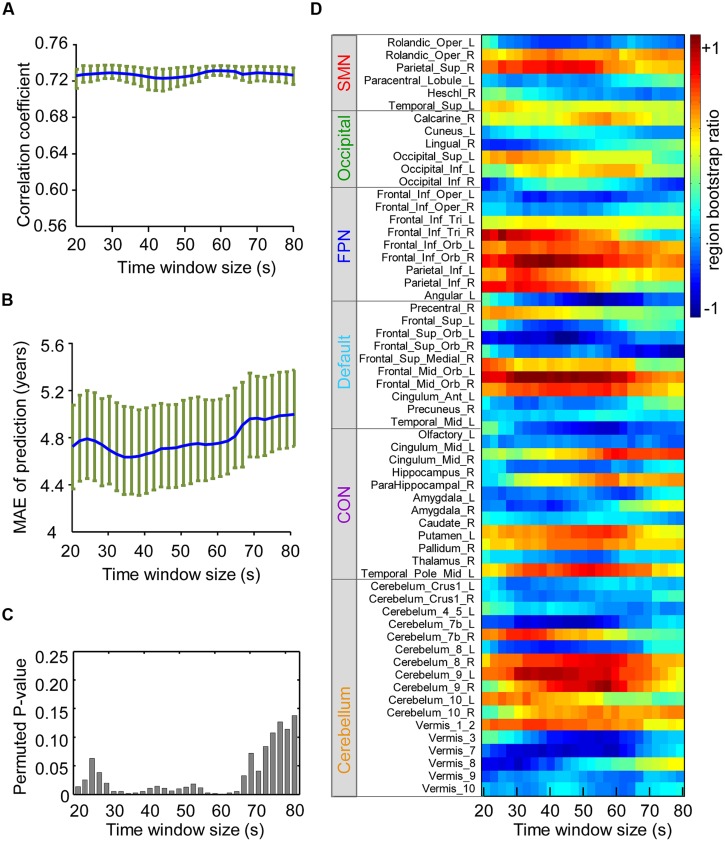
Influence of the sliding windows size on the results of partial least-squares analysis. SMN, sensorimotor network; OCC, occipital network; FPN, fronto-parietal network; (A) Correlation coefficients of the brain score and age with each time window size are shown in blue, and the green circle above indicate the confidence intervals. (B) Average MAE (±SE) curves for age prediction are shown in blue, and their confidence intervals with each time window size are shown in green. (C) The height of the bar in the figure indicates the upper border of the permuted P-value for correlation coefficients of the brain score and age with each time window size. (D) The figure reflects the stability of the region bootstrap ratios (1/2 the sum of the connection bootstrap ratios to and from the regions) with changing time window size, suggesting the stability of the spatial patterns of maturation-dependent connections. Due to the large number of regions, only the “predictive regions” were selected and shown. Positive values indicate regions with connections mainly showing increased dynamics with age, and negative values denote regions with connections showing decreased dynamics.